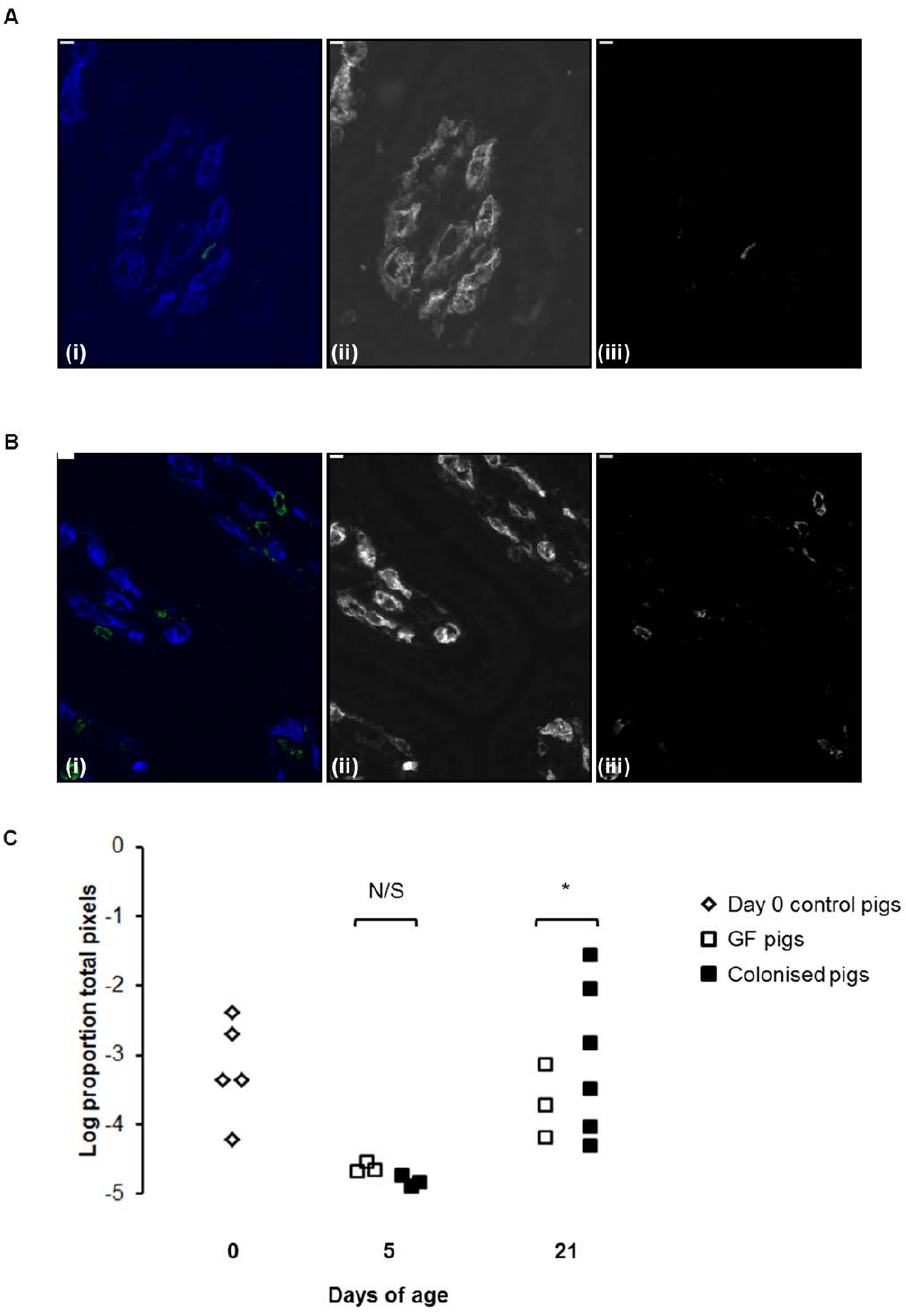
Figure 2. Colonisation expands mucosal CD4 + T cells by 21 days of age. (A) CD4 staining in jejunal mucosa from a GF pig and (B) a colonised pig at 21 days of age. Sections were stained with antibodies to CD4 (green) and capillary endothelium (MIL11; in blue). In both (A) and (B), (i) shows the two-colour image; (ii) shows the original greyscale image for the blue channel (endothelium); (iii) shows the original greyscale image for the green channel (CD4). Scale bar represents 10 m m. (C) Area of CD4 + T cell staining in jejunal sections from piglets at birth (open diamonds) and GF piglets (open squares) and colonised piglets (black squares) at 5 and 21 days of age (see Table 1 for numbers of piglets in each experiment). *p , 0.05.